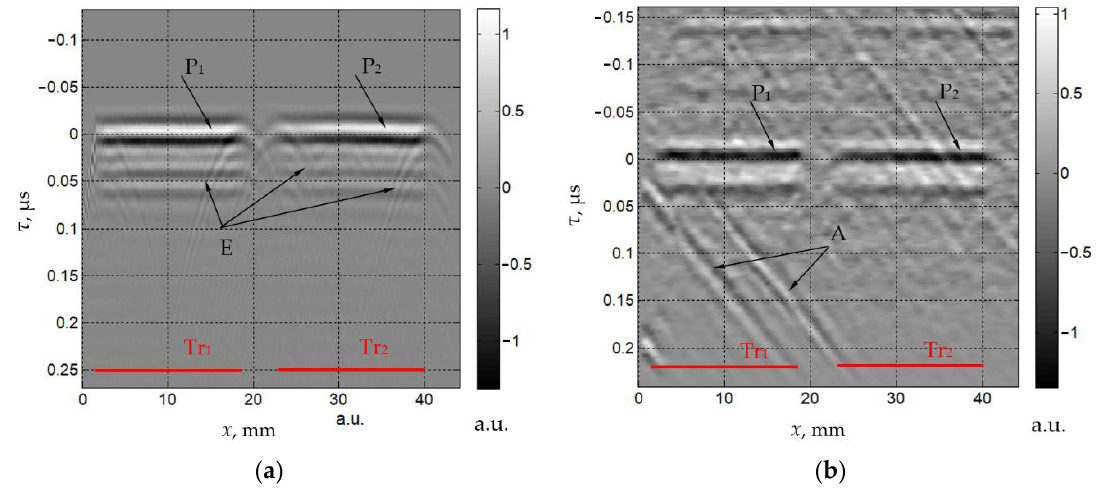
Figure 3. Measured spatio-temporal signals S L ( x ,τ) ( a ) and S T ( x ,τ) ( b ).